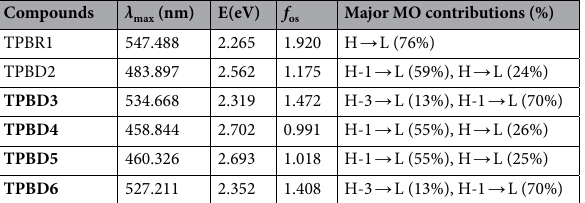
Table 4. Computed absorption responses of TPBR1 and TPBD2-TPBD6 in gas phase.